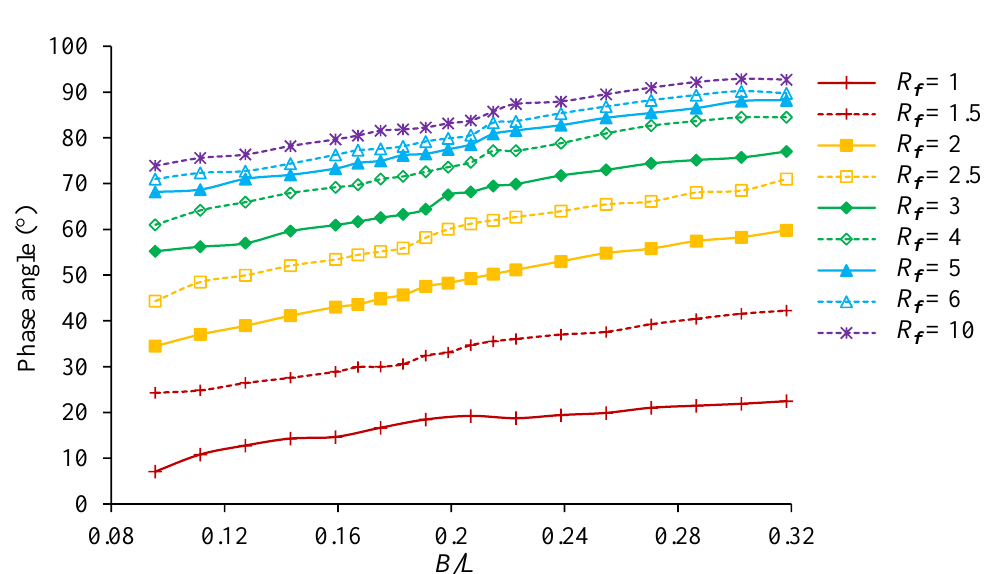
Figure 8. The phase between the floating OWC displacement and surface elevation at the centre of the OWC for K t = 3000 Pa·m −3 ·s and vertical motion at m = 2.